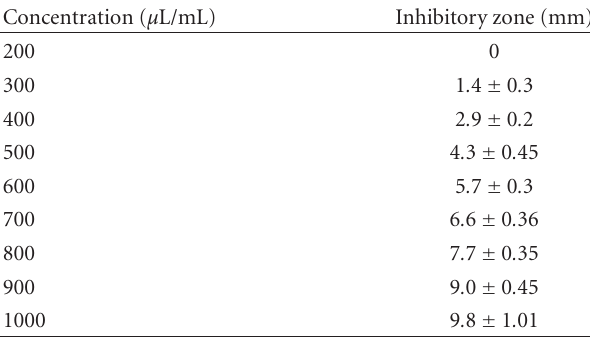
Table 2: Inhibitory zones in BHI agar inoculated with mixture of E. coli O157:H7 strains that formed around the wells due to the present of xoconostle extract at di ff erent concentrations (v/v) after 12h of incubation at 37 ◦ C. Concentrations are in µ L adjusted to 1mL by distilled water and inhibitory zone = diameter of the zone − 8 mm (diameter of the well). Data represent the average of three replicates with standard